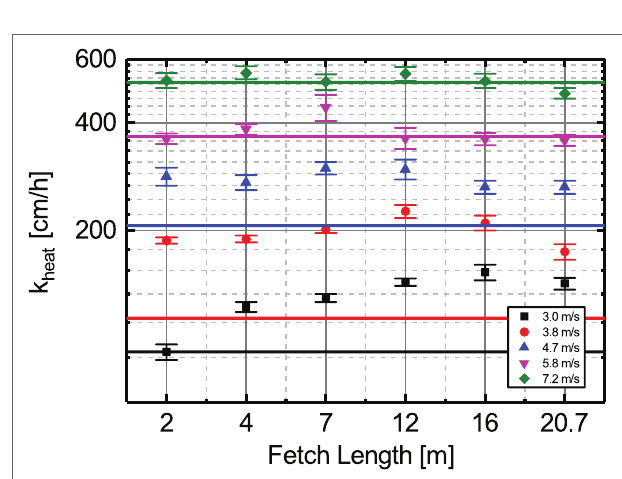
FigURe 17 | Heat transfer velocities measured at different fetch length in the Heidelberg wind-wave facility Aeolotron. The fetch length was varied by moving a wave absorber along the annular water channel. The solid lines represent the heat transfer velocity for infinite fetch. For low wind speeds, a clear dependency of the heat transfer velocity on the fetch length can be